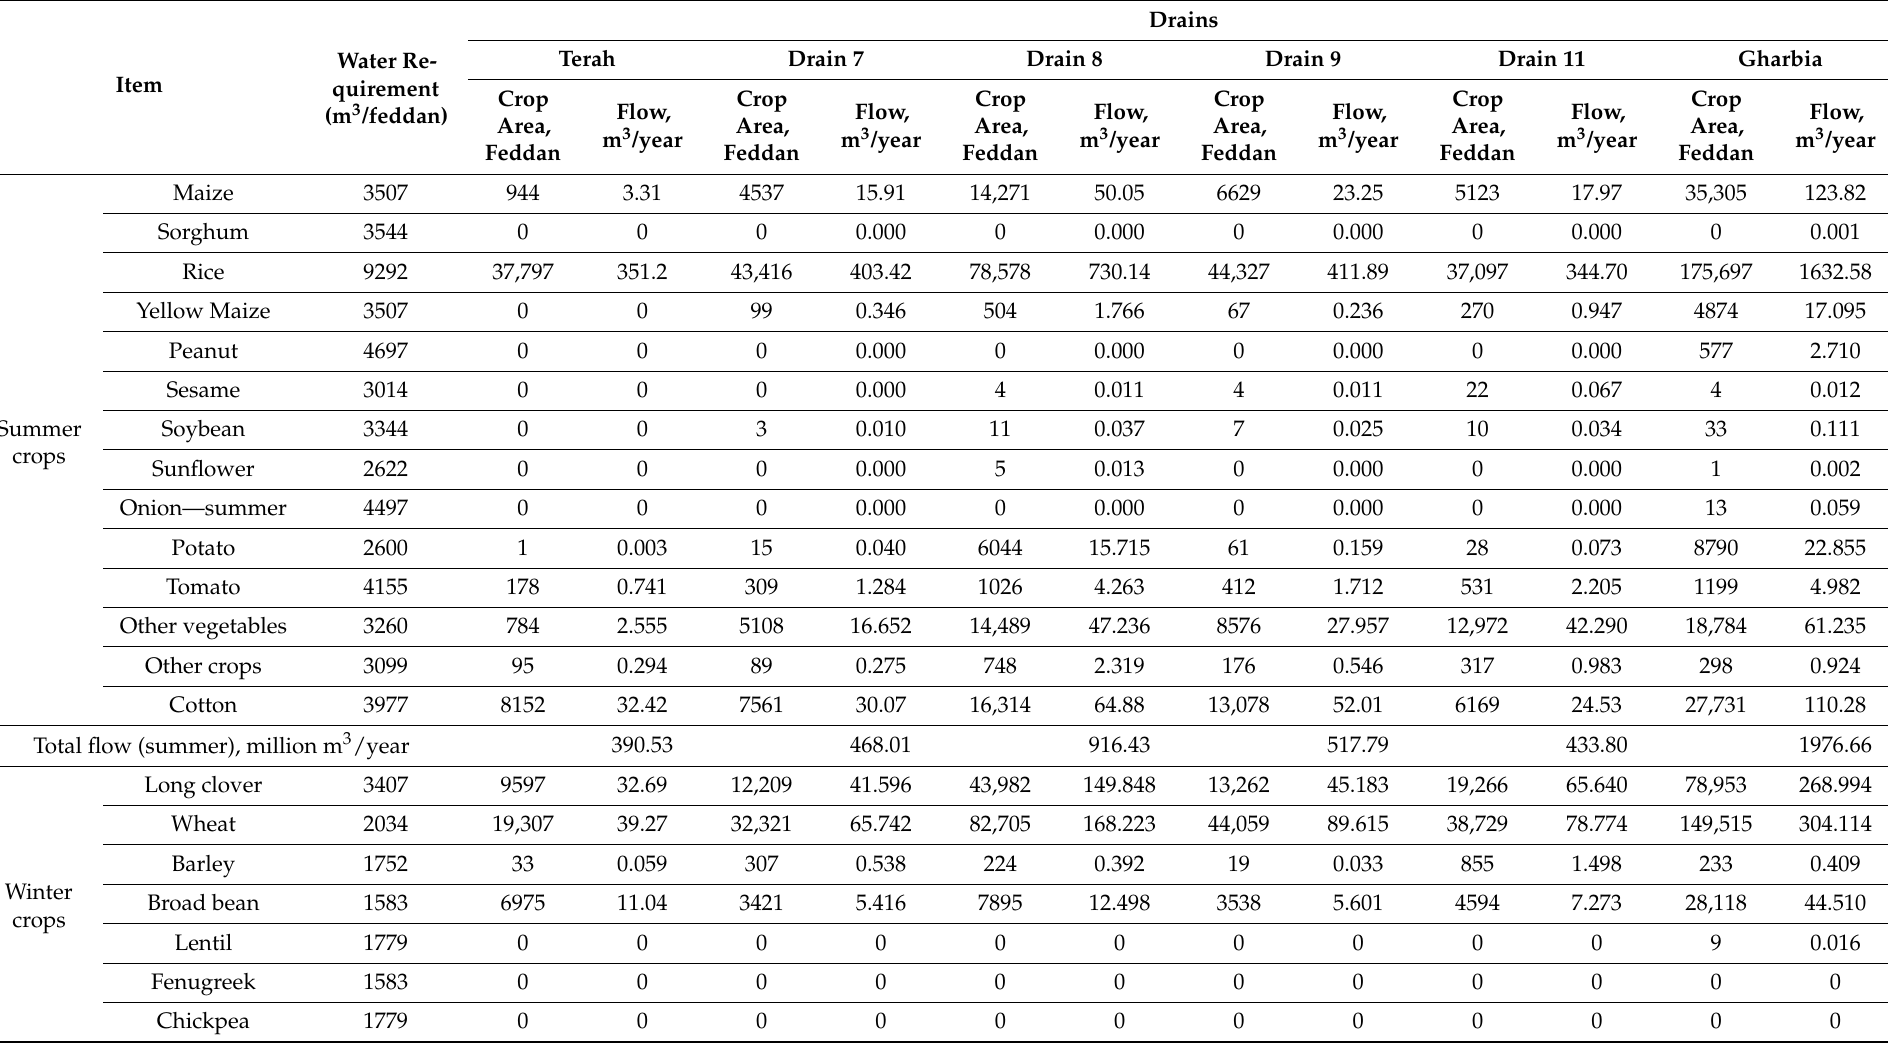
Table 1. Catchment area of each agricultural drain in feddan with the corresponding